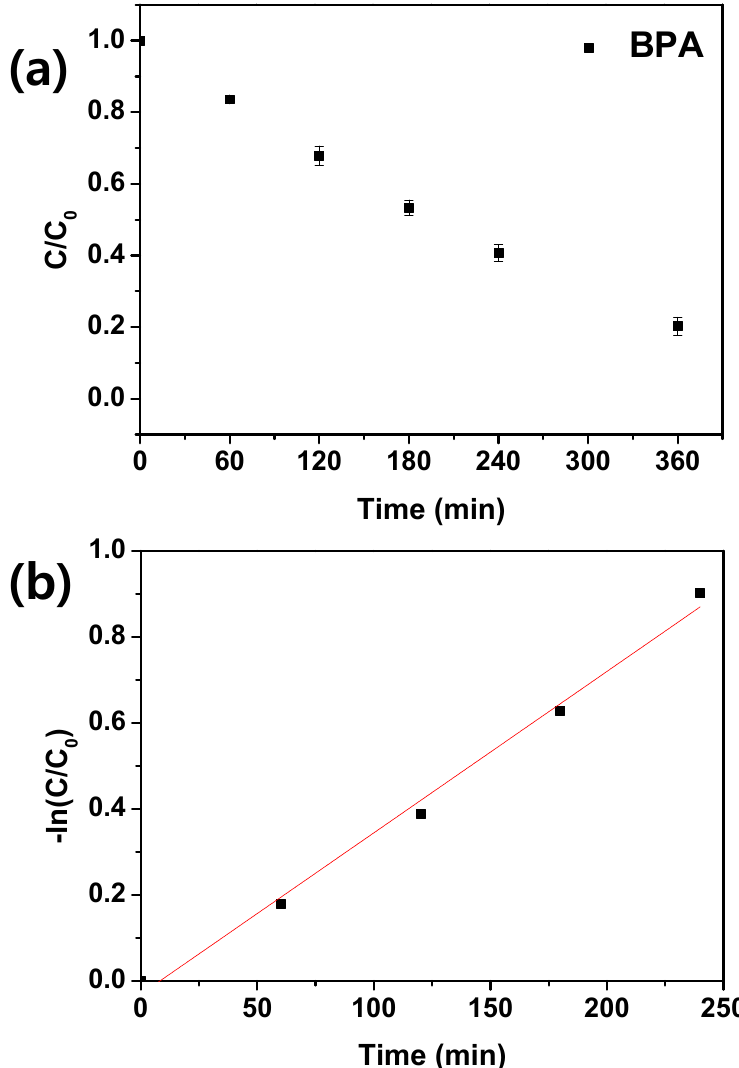
Figure 8. ( a ) Degradation of bisphenol A (BPA) by 4% PANI/TiO 2 under visible-light irradiation, and ( b ) pseudo-first-order kinetics of BPA degradation (BPA = 5 mg/L, catalyst dose: 0.8 g/L).